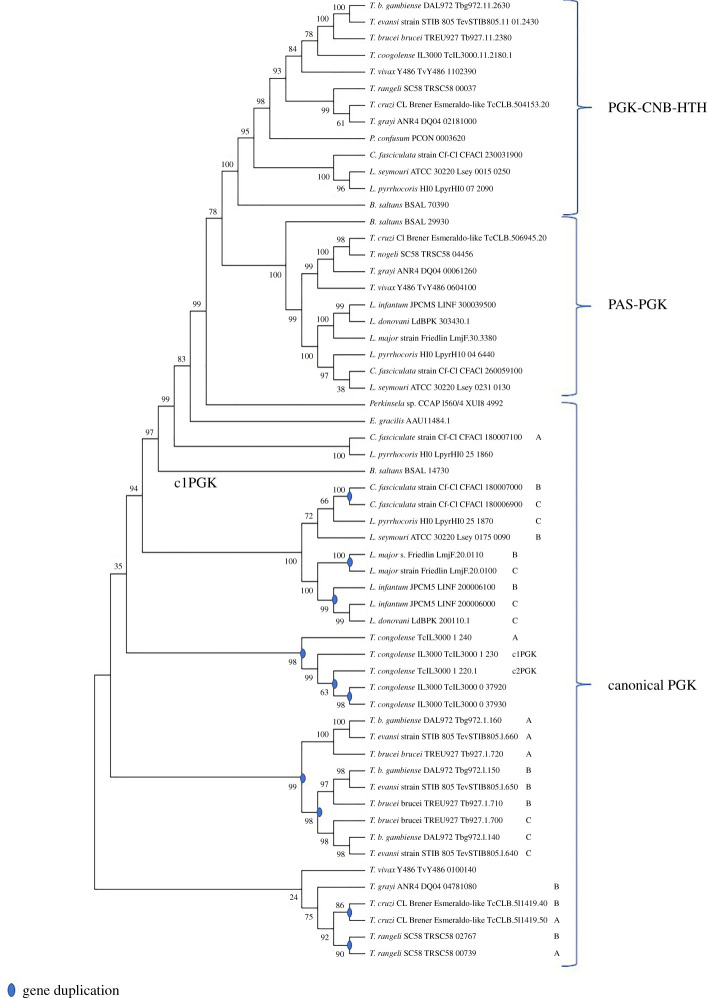
Kinetoplastid phylogenetic tree based on PGK sequences. PGK gene sequences were retrieved from the TriTrypDB, GeneDB and GenBank databases [94,123,360], and the predicted amino acid sequences aligned using Muscle (EMBL-EBI) [95]. Regions of uncertain alignment were omitted from the analysis leaving a total of 57 sequences (19 taxa) and 268 amino acid positions. The evolutionary history was inferred using the neighbour-joining (NJ) and the maximum parsimony (MP) methods [361], with similar results. The branches of the tree represent sequences, orthologous and paralogous, from different members of the Kinetoplastea phylum, with nodes depicted as filled blue ovals representing gene duplication events. Support for the nodes in the NJ and MP analyses was evaluated using the bootstrap procedure, and in each case, the bootstrap consensus tree inferred from 1000 replicates [362] was taken to represent the evolutionary history of the taxa analysed [362]. Branches corresponding to partitions reproduced in less than 50% bootstrap replicates are collapsed. The percentage of replicate trees in which the associated taxa clustered together in the bootstrap test (1000 replicates) are shown next to the branches [362]. For the NJ analysis, the evolutionary distances were computed using the p-distance method [363] and are given in the units of the number of amino acid differences per site. This analysis involved 58 amino acid sequences. All positions containing gaps and missing data were eliminated (complete deletion option). There were a total of 268 positions in the final dataset. For the MP analysis branches corresponding to partitions reproduced in less than 50% bootstrap replicates are collapsed. The percentages of replicate trees in which the associated taxa clustered together in the bootstrap test (1000 replicates) are shown next to the branches [361]. The MP tree was obtained using the subtree-pruning-regrafting (SPR) algorithm ([362], p. 126)] with search level 1 in which the initial trees were obtained by the random addition of sequences (10 replicates). This analysis involved 57 amino acid sequences. There were a total of 391 positions in the final dataset. Evolutionary analyses by NJ and MP were conducted in MEGA X [364].